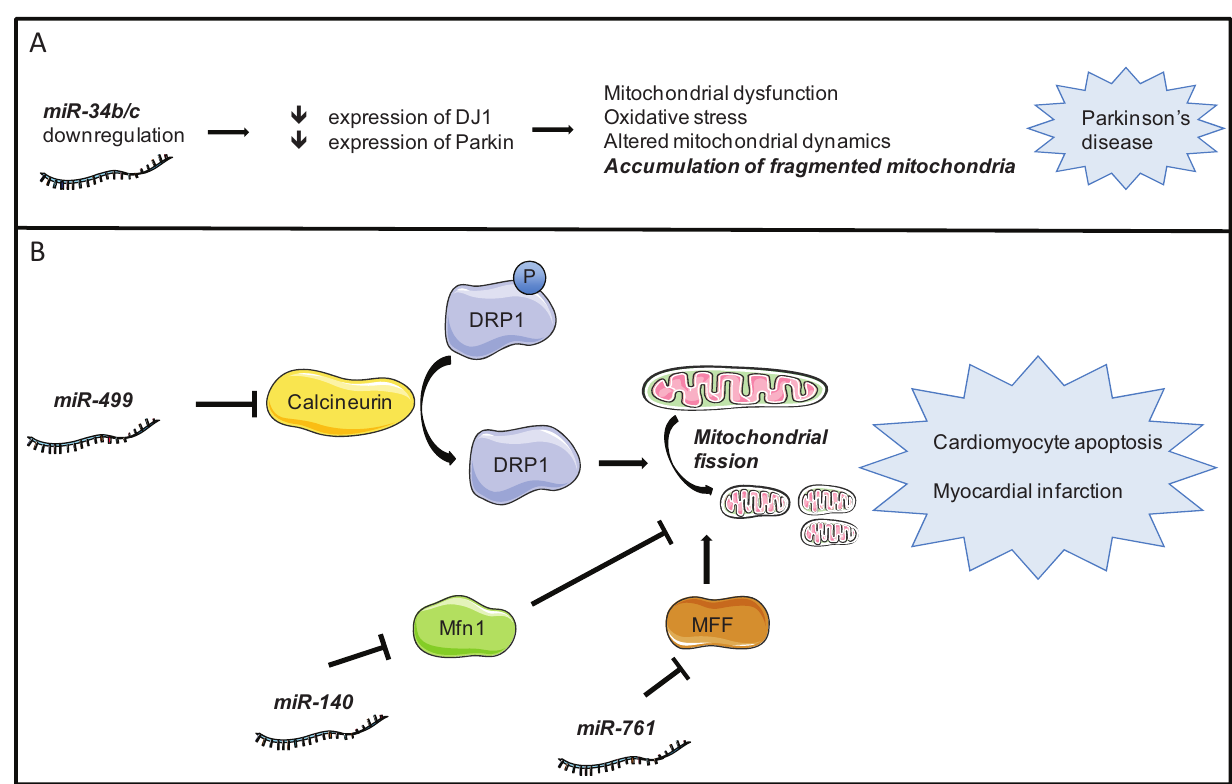
Figure 2. Schematic representation of mitochondrial fission modulation by miRNAs in disease. ( A ) In the brain, downregulation of miR-34b/c is associated with reduced expression of DJ1 and Parkin proteins, which in turn can lead to mitochondrial fragmentation and dysfunction, causing Parkinson’s disease; ( B ) In cardiomyocytes, the modulation of mitochondrial fusion/fission proteins lead to mitochondrial fragmentation and cardiomyocyte apoptosis/myocardial infarction. The expression of miR-499 or miR-761 and the downregulation of miR-140 could prevent mitochondrial fission and apoptosis. DRP1, dynamin-related protein-1; Mfn1, mitofusin 1; MFF, mitochondrial fission